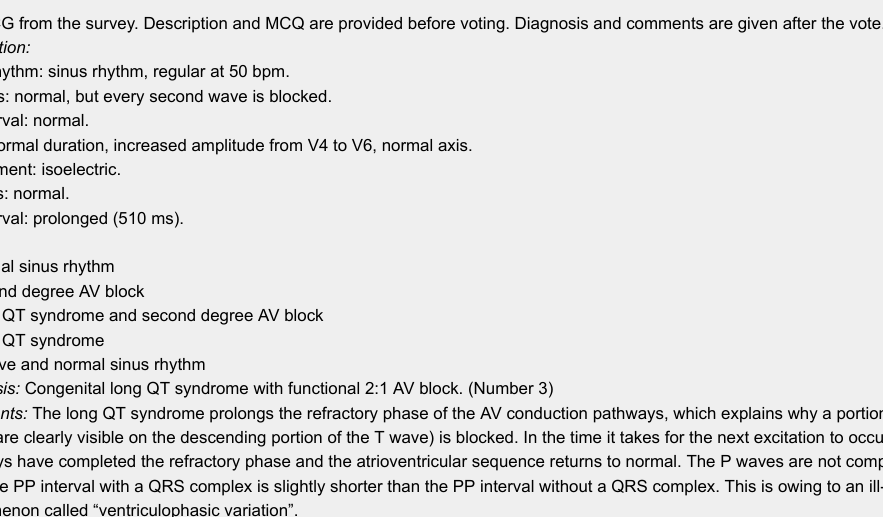
5. U wave and normal sinus rhythm Diagnosis: Congenital long QT syndrome with functional 2:1 AV block. (Number 3) Comments: The long QT syndrome prolongs the refractory phase of the AV conduction pathways, which explains why a portion of the P waves (which are clearly visible on the descending portion of the T wave) is blocked. In the time it takes for the next excitation to occur, the conduction pathways have completed the refractory phase and the atrioventricular sequence returns to normal. The P waves are not completely regular, since the PP interval with a QRS complex is slightly shorter than the PP interval without a QRS complex. This is owing to an ill-explained phenomenon called “ventriculophasic